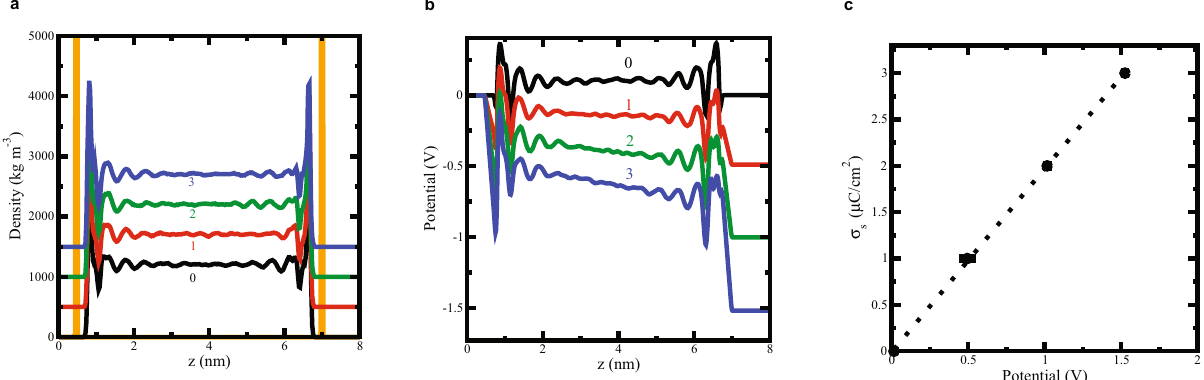
Fig. 4 Results of molecular dynamics simulations for PC. a Density pro fi les of liquid PC at different charge densities, 0, 1, 2 and 3 µ C cm − 2 (The densities have been shifted vertically by 500 units for clarity). b Electrostatic potential drop for the same systems, as represented in the left panel; left and right electrodes are positively and negatively charged, respectively. c Variation of the voltage with the surface charge density. The straight line represents the linear fi tting to the data. The computed capacitance for this system is 1.98 µ F cm − 2